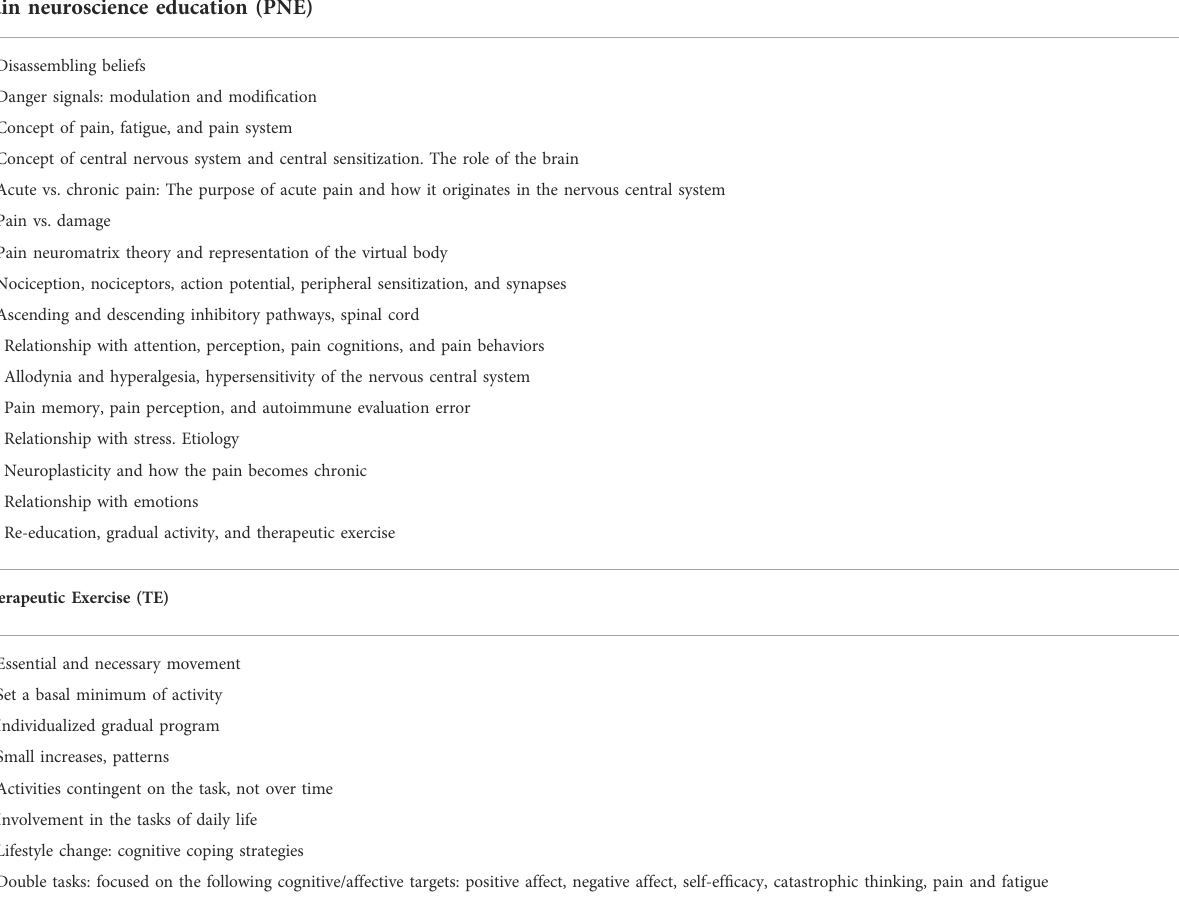
TABLE 2 Contents of the FIBROWALK program (i.e., Pain Neuroscience Education, Therapeutic Exercise, Cognitive Behavioral Therapy, and Mindfulness Training). Pain neuroscience education